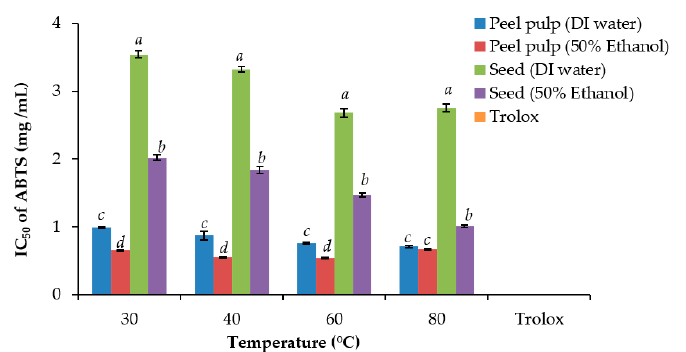
Figure 4. ABTS IC 50 of jujube peel pulp and seeds extracted with DI water and 50% ethanol at different temperatures. The error bar represents the standard error of the mean. The temperatures in the histogram with the same letter were not significantly different at the 5% level, according to the results of the LSD test.